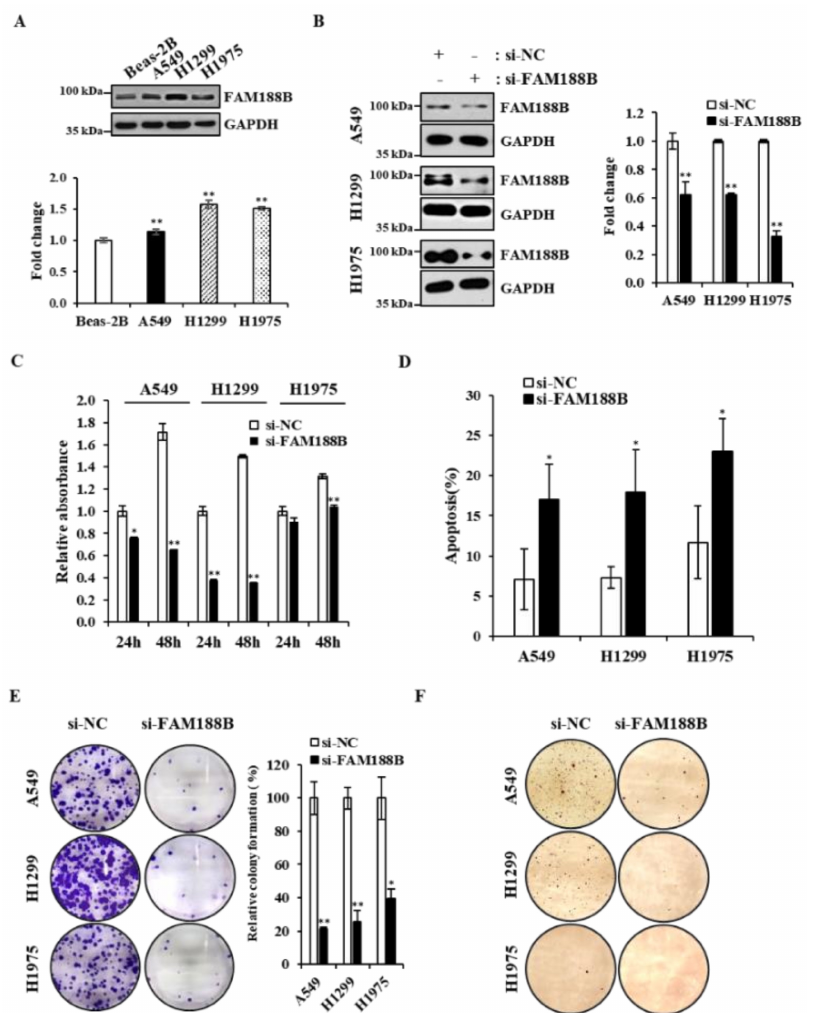
Figure 1. Effects of FAM188B knockdown on cell viability in lung cancer cells ( A ) Beas-2B, A549, H1299, and H1975 cells were processed for immunoblot analysis using indicated antibodies (up- per panel). The levels family with sequence similarity 188 member B (FAM188B) were quantified by densitometry and normalized to Beas-2B (lower panel). GAPDH was used as a loading